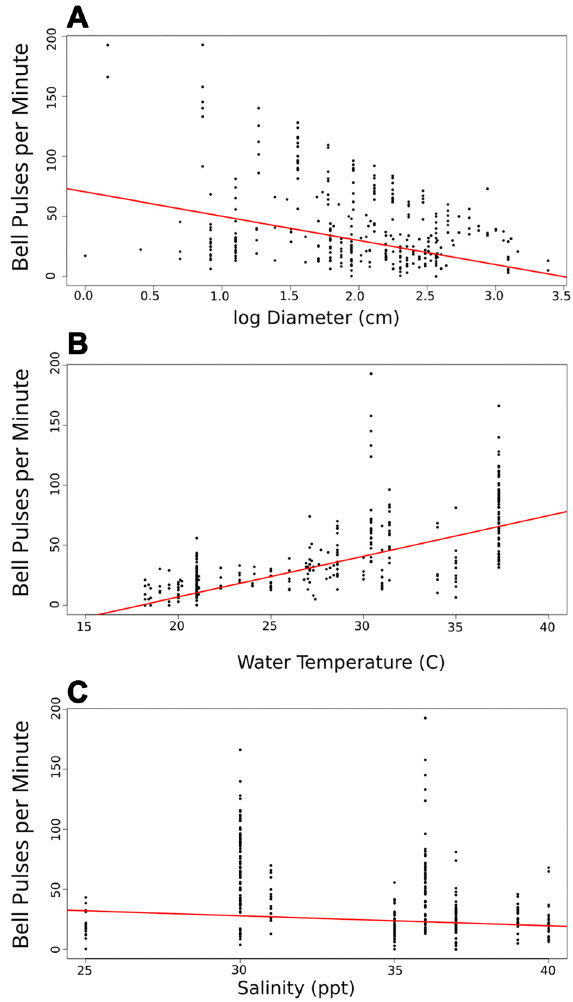
Figure 5. Pulse rate model. A multiple linear regression correlating bell pulsation rate to ( A ) log of jellyfish diameter (R 2 = 0.34), ( B ) water temperature (R 2 = 0.42), and ( C ) salinity (R 2 = 0.07). This model explained a majority of the variation in bell pulse rates (n = 330, R 2 = 0.57). Pulse rate correlated negatively with the natural log of diameter, positively with temperature, and no correlation was observed with salinity.